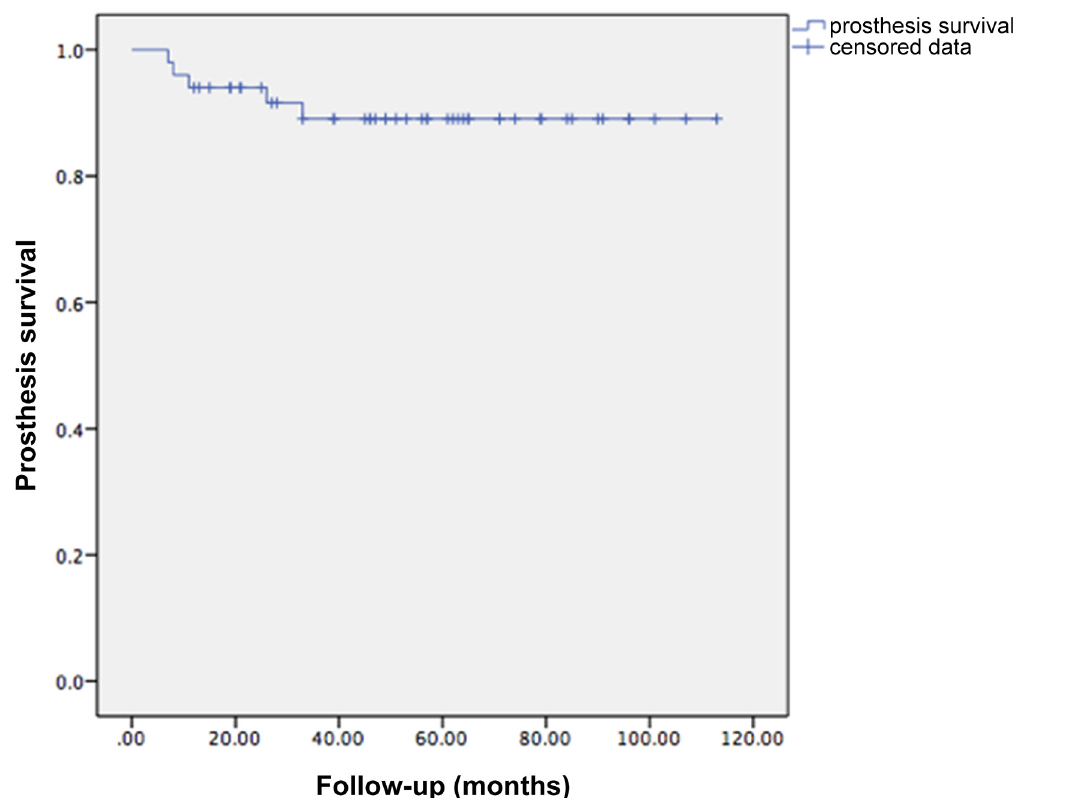
Fig 4. Prosthesis survival. A Kaplan-Meier survival curve showing prosthesis